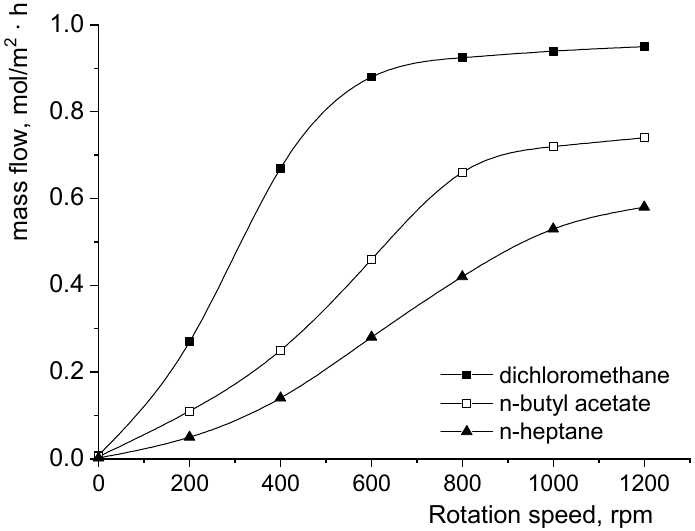
Figure 2. Influence of the impellers’ rotation speed on the fumaric acid mass flow from the pure aqueous phase to the organic phase without 1 ‐ octanol.